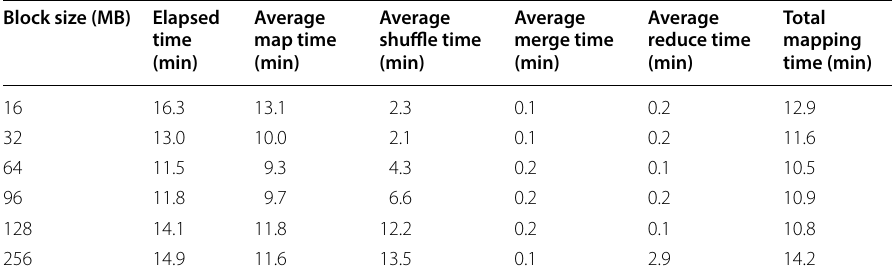
Table 4 Clustering (1.9 GB) raster image with a 2 node Hadoop cluster Block size (MB) Elapsed time